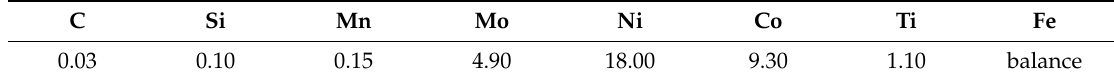
Table 1. The complete chemical composition of X3NiCoMoTi18-9-5 steel (in wt